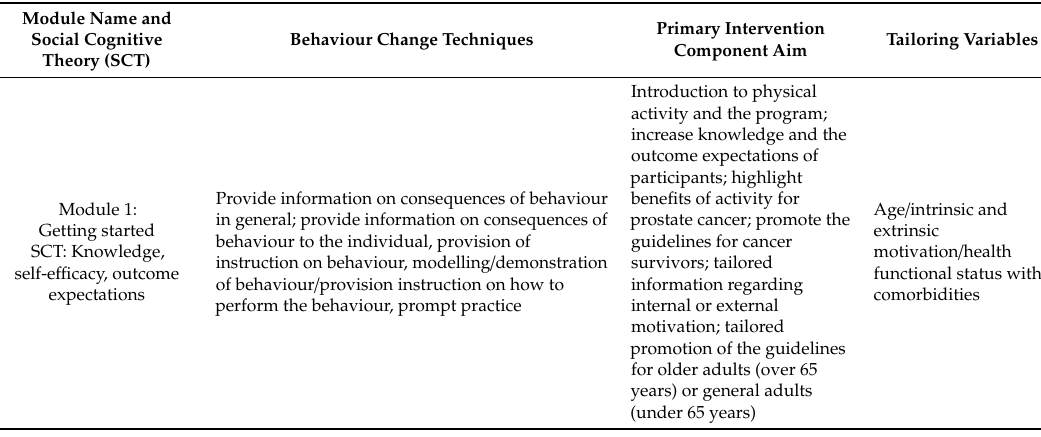
Table A1. PCHF intervention modules and additional